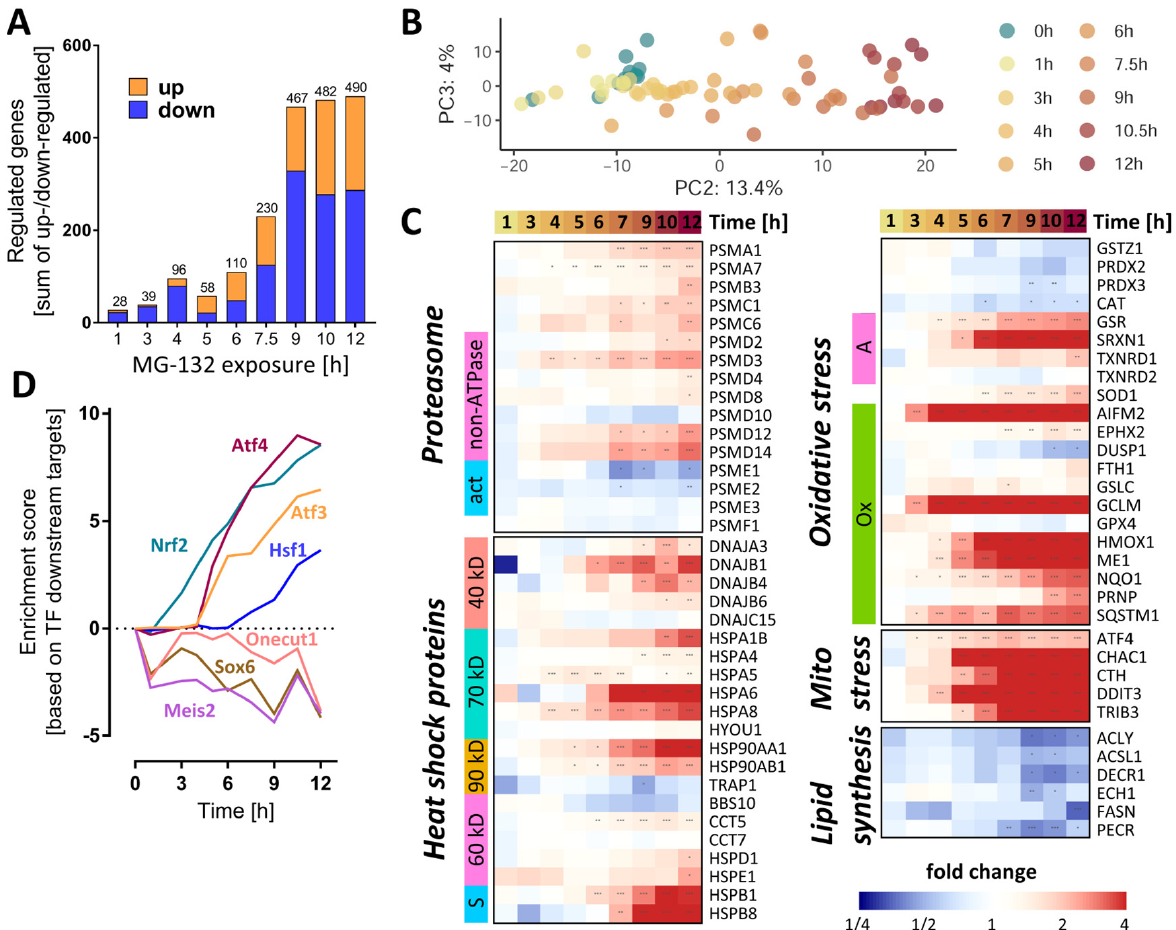
2 Figure 4. Dynamics of the MG-132-induced transcriptomic changes over time. Transcriptome